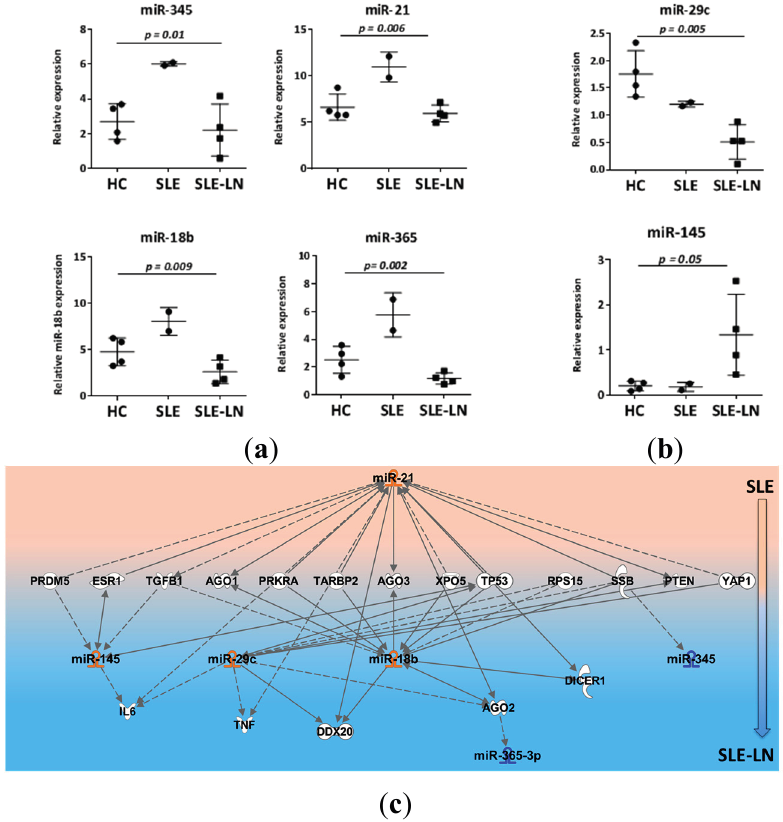
Figure 3. miRNAs discriminate SLE from SLE-LN patients independently on the B cell subset. Expression levels of miRNAs were detected in CD27 + and CD27 − B cells using real-time RT-PCR. For normalization, the mean CT value of all miRNAs analyzed and two housekeeping snoRNA genes (RNU48 and RNU44) were used. Each dot represents the mean value for CD27 − and CD27 + B cell subsets. ( a ) Expression of four miRNAs is similar for the SLE-LN and HC patients, but their expression is different between SLE and SLE-LN; ( b ) Expression of two miRNAs is different between SLE-LN and SLE or HC patients. Results are expressed as mean ± SD of individual samples of six SLE patients and four HC. p -values of the one-way ANOVA test are indicated on each graph; and ( c ) Hierarchical layout of the putative target genes predicted from miRNAs differentially expressed between SLE and SLE-LN was built using Ingenuity Pathway Analysis (IPA). Direct or indirect interactions are indicated by line or dotted line,